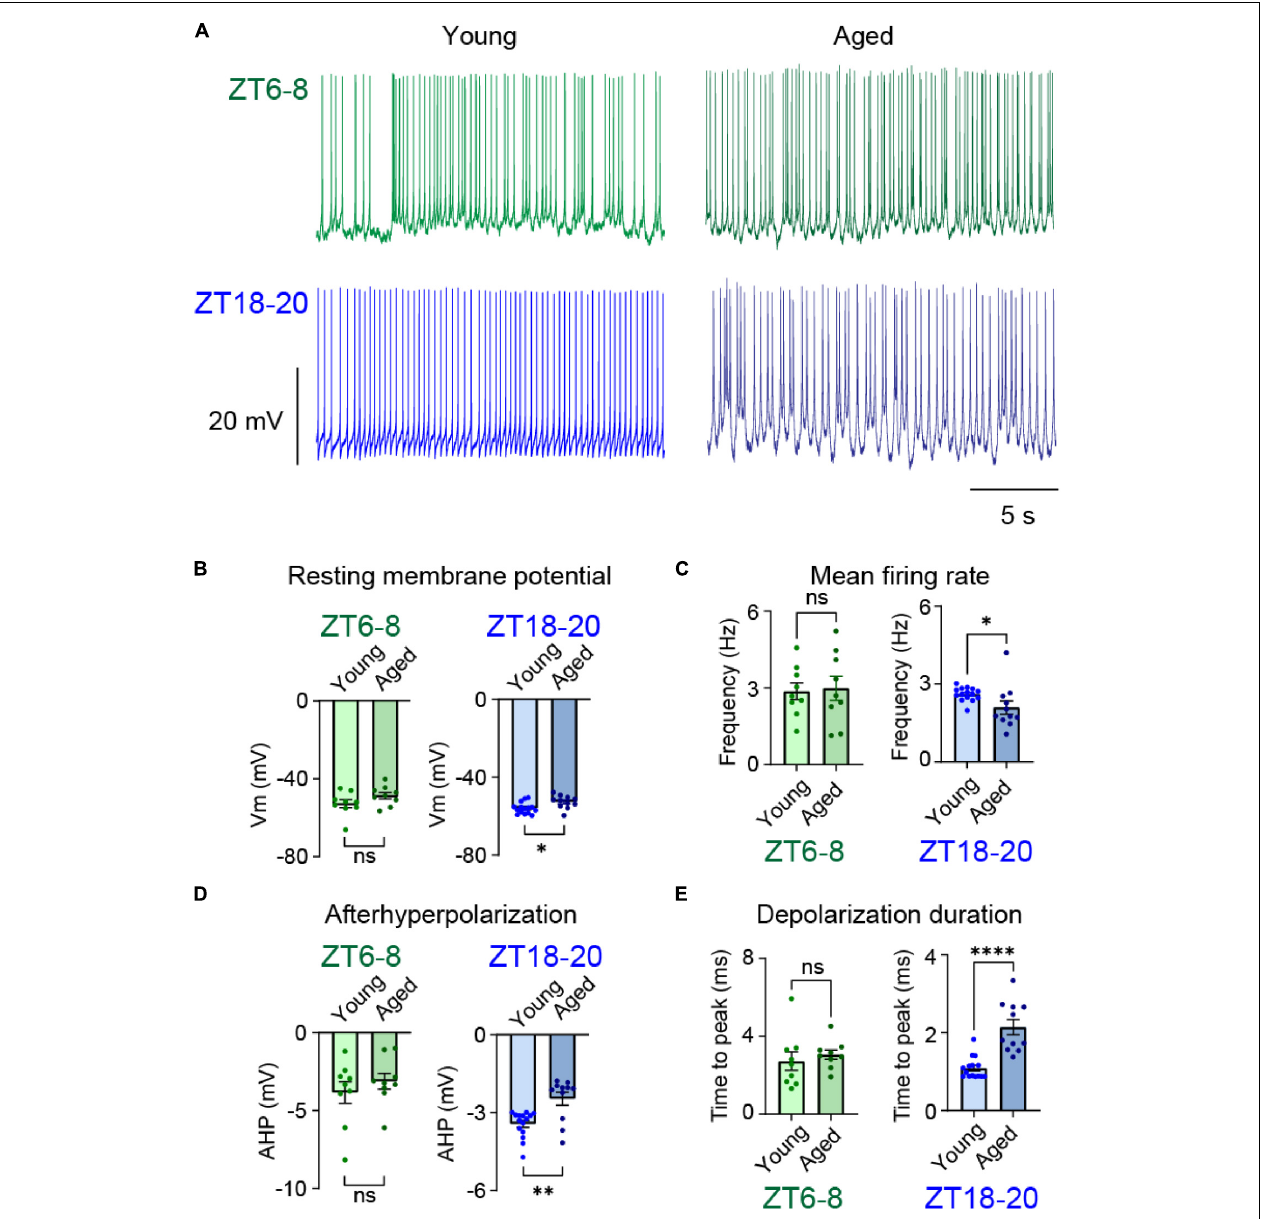
FIGURE 1 | Aging altered the membrane potential dynamics of DN1p neurons at ZT18-20. (A) Representative membrane potential traces of spontaneous firing in young and aged DN1p neurons at ZT6–8 and ZT18–20. (B–E) Quantifications of resting membrane potential (B) , mean firing rate (C) , afterhyperpolarization amplitude (D) , and spike onset depolarization duration defined as time from threshold to peak depolarization (E) in young and aged DN1p neurons at ZT6–8 and ZT18–20 (ZT6–8, young: n = 9, aged: n = 9; ZT18–20, young: n = 15, aged: n = 11). ∗ p < 0.05, ∗∗ p < 0.01, and ∗∗∗∗ p < 0.0001 based on t